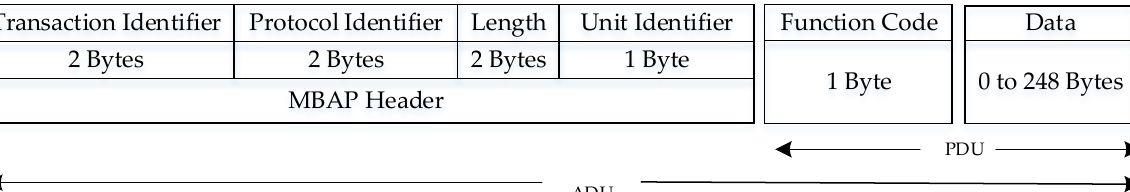
Figure 2. The frame structure of the Modbus TCP in the data link layer.